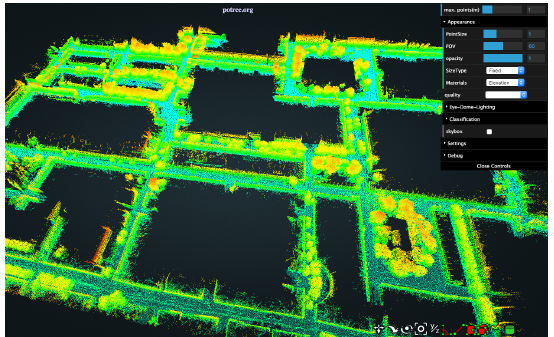
Figure 4. The figure is a snapshot of the Potree user interface. The 3D data shows London Bloomsbury area. The color encodes the height information